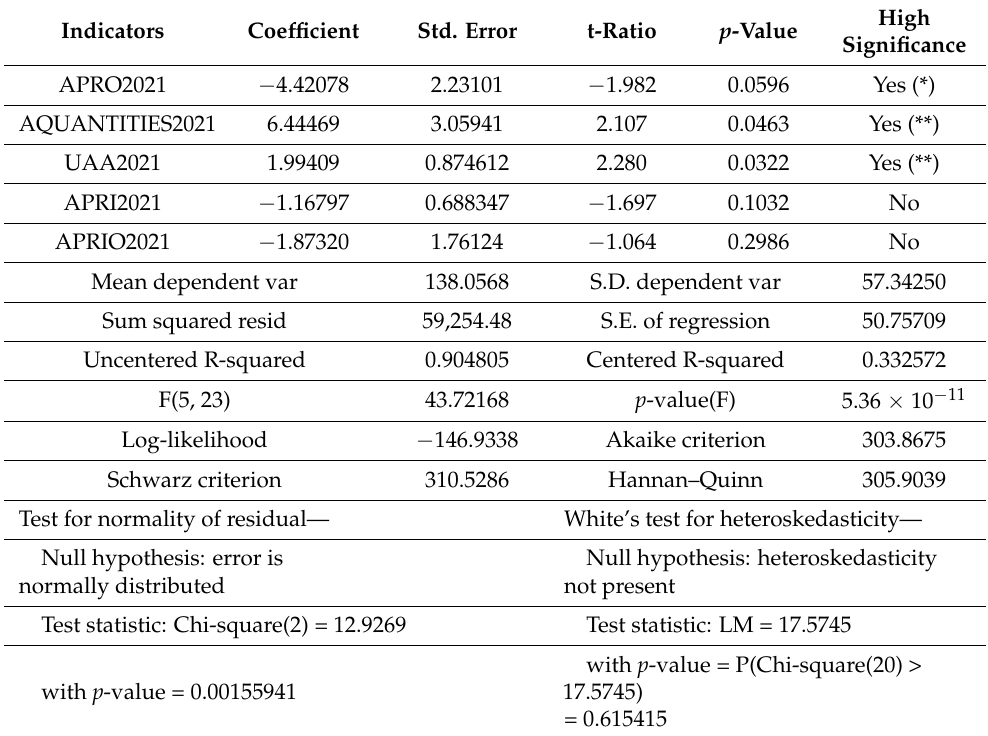
Table 11. Model 2021: OLS, using observations 1–28 (Dependent variable: